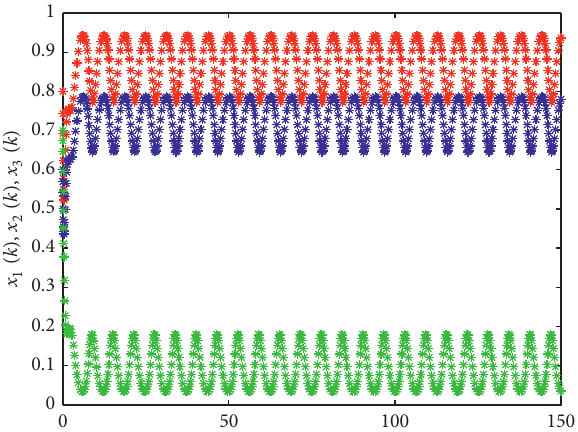
, the blue line represents x 1